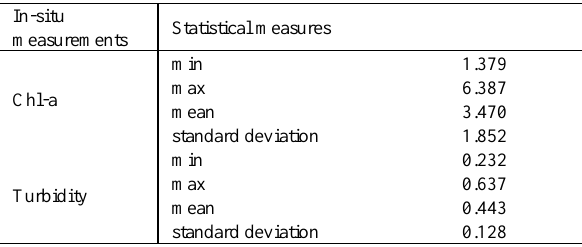
Table 2. Statistical measures related to in-situ